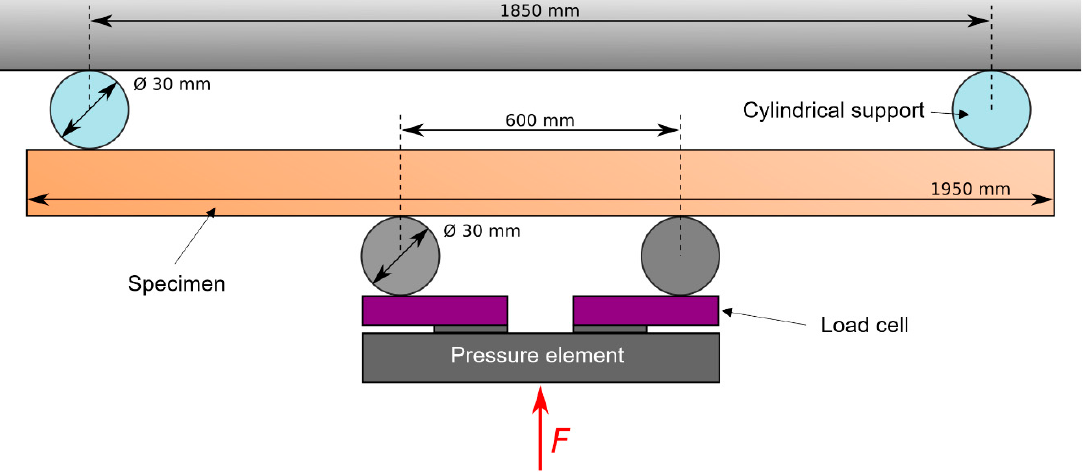
Figure 13. Four-point bending test and its main components.